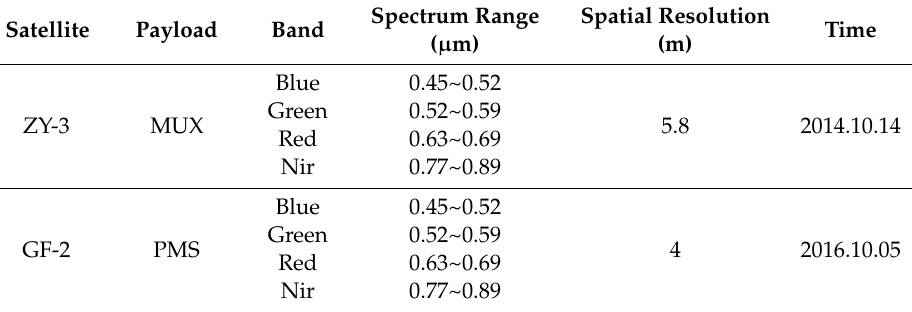
Figure 1. True-color images and reference change maps of the three datasets. ( a , b ) True-color images in the first dataset. ( c ) Reference change map of the first dataset. ( d , e ) True-color images in the second dataset. ( f ) Reference change map of the second dataset. ( g , h ) True-color images in the third dataset. ( i ) Reference change map of the third dataset. ( a , d , g ) are ZY-3 satellite images. ( b , e , h ) are GF-2 satellite images. Table 1. Information of ZY-3 and GF-2 images used in this study.